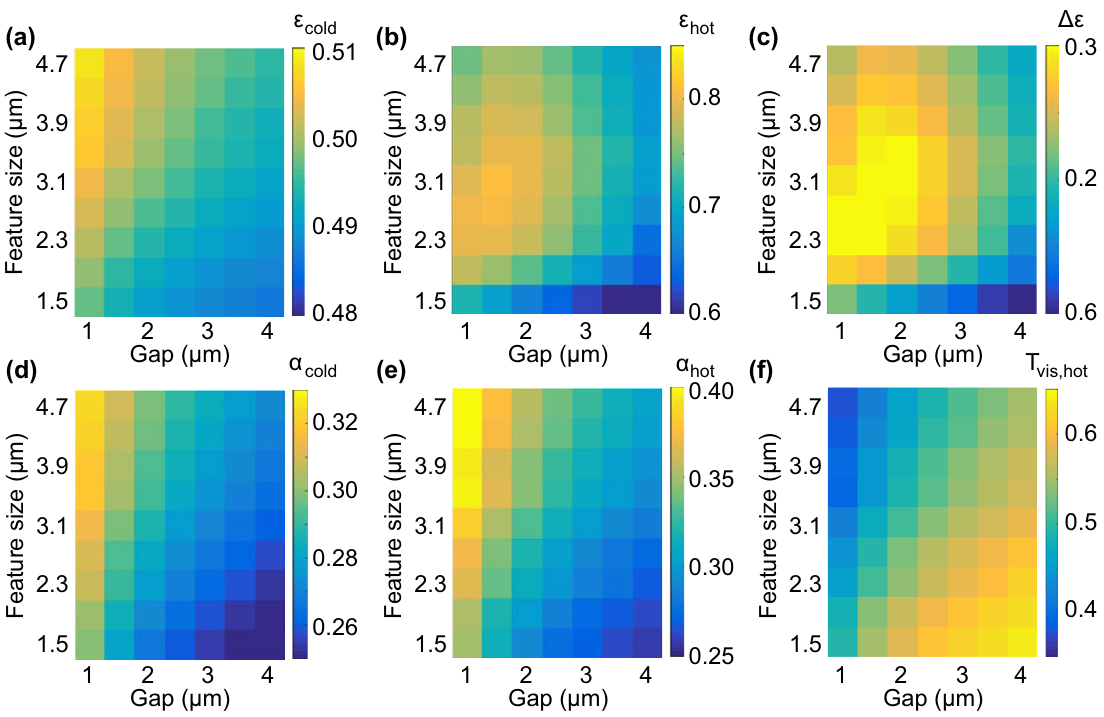
Figure 3: Design optimization as 2D sweep of VO 2 square feature size L and gap d through numerical simulations. (a) IR emissivity in cold state ɛ cold ,(b)IRemissivityinhotstate ɛ hot ,(c)IRemissivitycontrast Δ ɛ ,(d)solarabsorptionincoldstate α cold (e)solarabsorptioninhotstate α hot . (f) Visual transmission in the hot state, T vis, hot . Calculations based on space